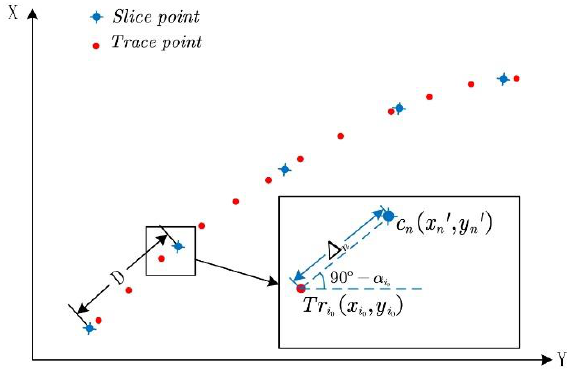
Figure 2. The position of the slicing point